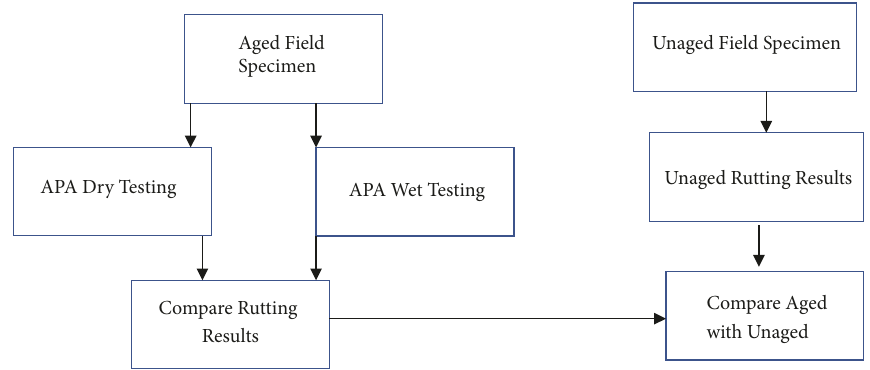
Figure 1: Flow chart for testing and analyzing the